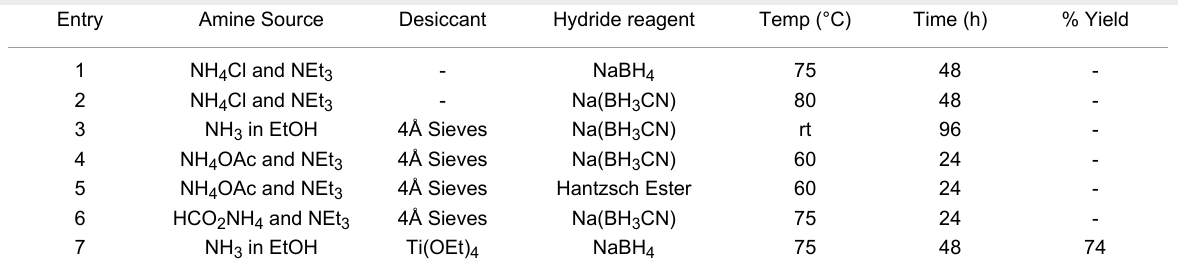
Table 1: Summary of our efforts to effect quinolizidine formation in a one-pot